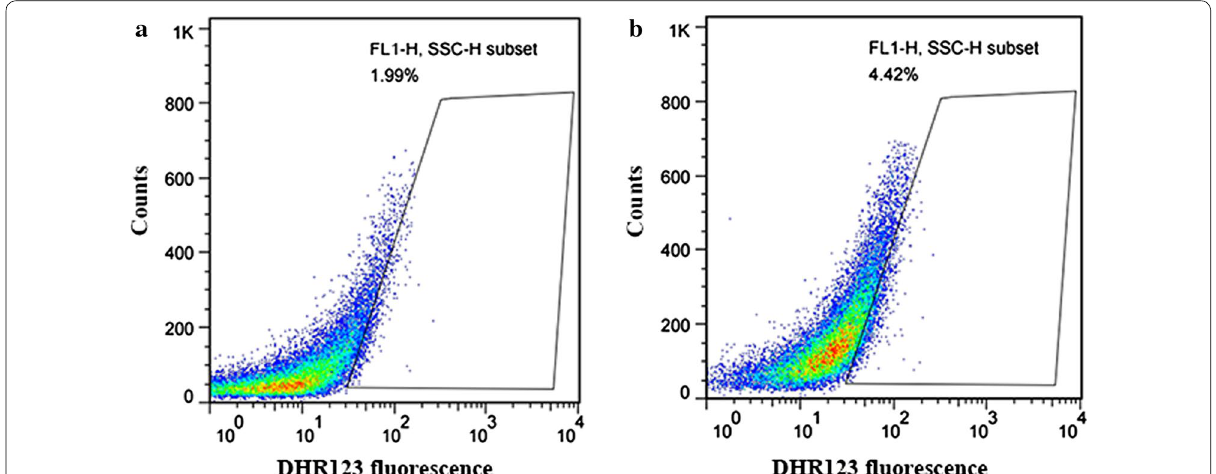
Fig. 8 The intracellular ROS in P. pastoris GS115/ LacB ( a ) and P. pastoris GS115m/ LacB ( b ) using DHR-123. Fluorescence intensities in ~ 20,000 cells were monitored by flow